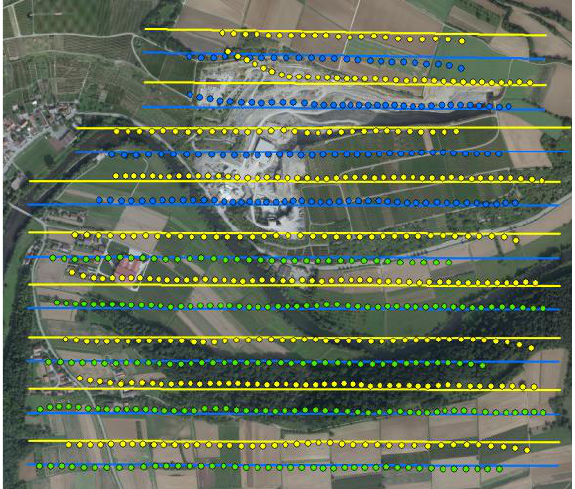
Figure 4: Test-site Vaihingen/Enz, with signalized points overlaid to shaded DSM from airborne LiDAR